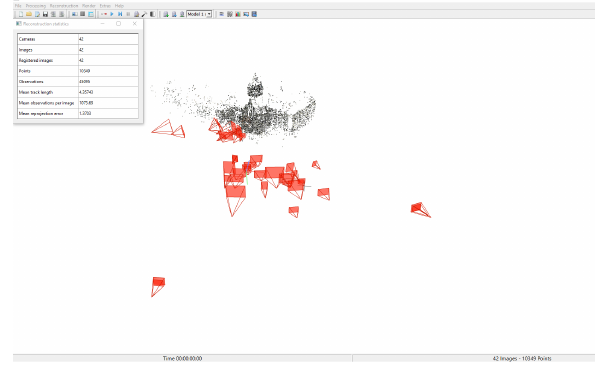
Figure 3. The historical model generated using exclusively historical images with a final reprojection error of 1.37 pixels.